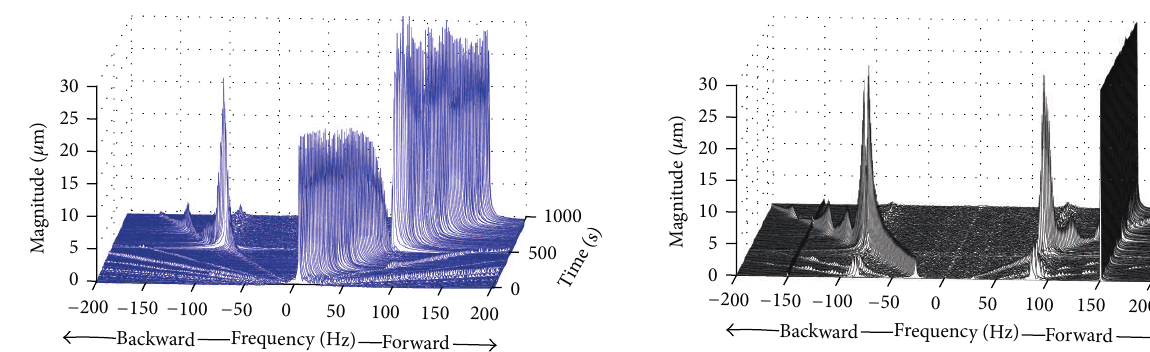
Figure 11: Full spectrum waterfalls at backward